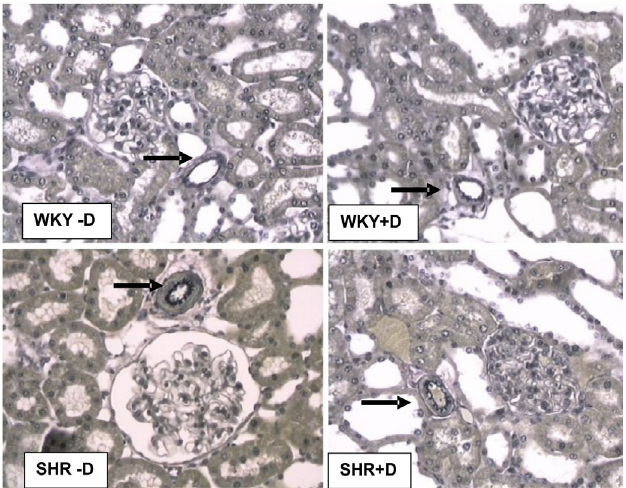
FIGURE 2 - Effect of D- a -tocopherol on thickness of interlobular artery wall (arrow) in SHR and control rats. Representative Verhoeff-stained sections are shown. Magnification: 200x.